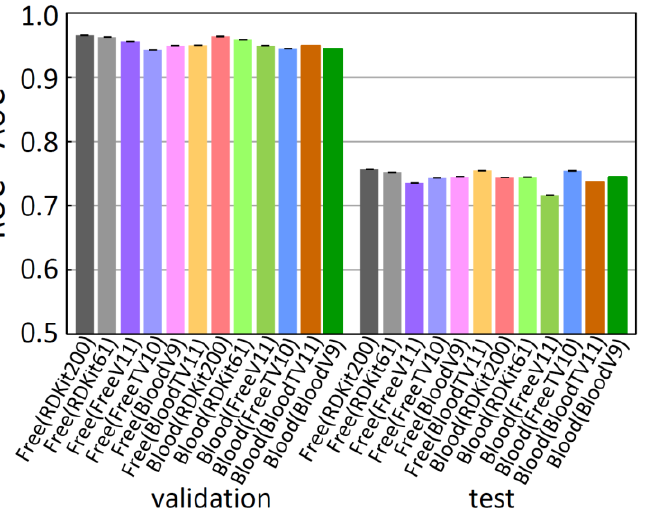
Figure 8. ROC-AUC scores of the prediction for the free-form and in-blood-form datasets obtained by RF method. Descriptor set is in parentheses.